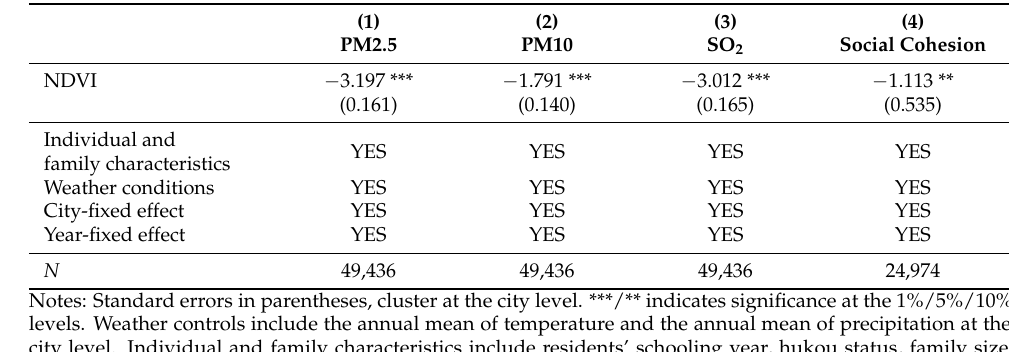
Table 9. Improving air